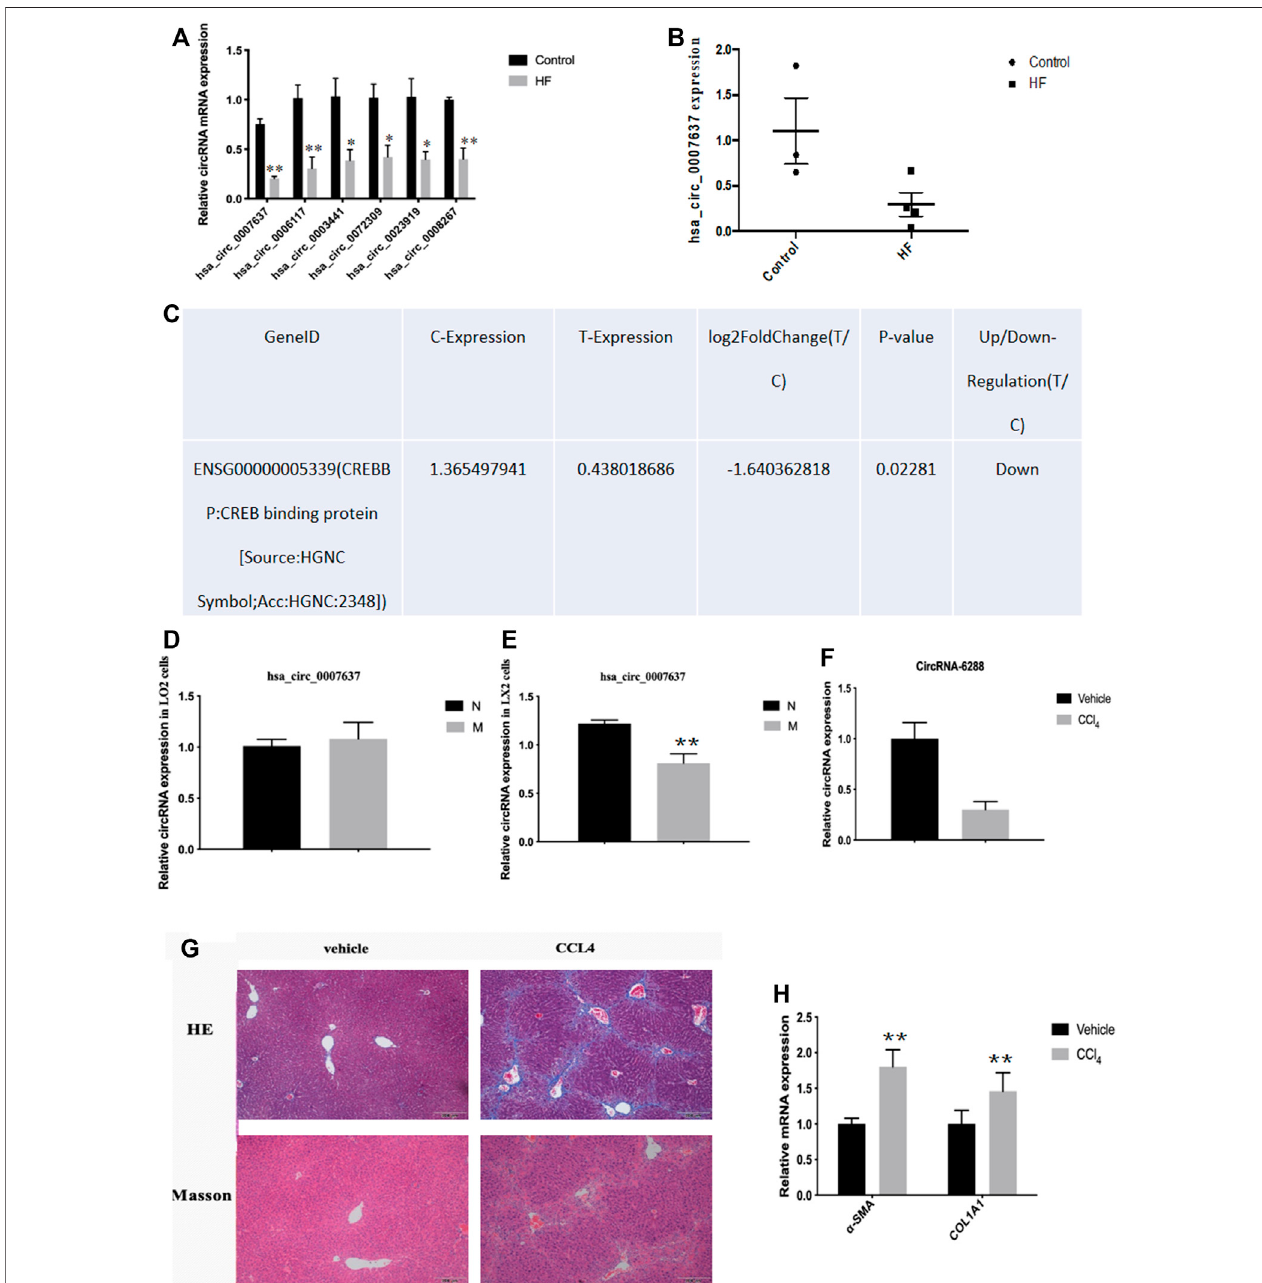
FIGURE 3 | Expression level of circCREBBP decreased in HF tissues. The malregulated circRNAs using qRT-PCR, which was consistent with circRNA-seq data. We focused on circCREBBP (hsa_circ_0007637), which signi fi cantly downregulated in HF tissues (A – C) . The expression level of hsa_circ_0007637 in in human L0-2 and LX-2 cells stimulated by TGF- β 1 and we found that hsa_circ_0007637 was decreased (D,E) . It was also established a mouse model of HF (F – H) .